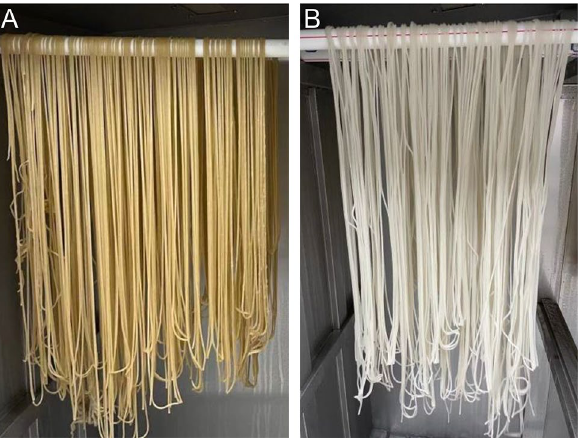
Figure 2. Images showing the brown ( A ) and white rice noodles ( B ) processed in this